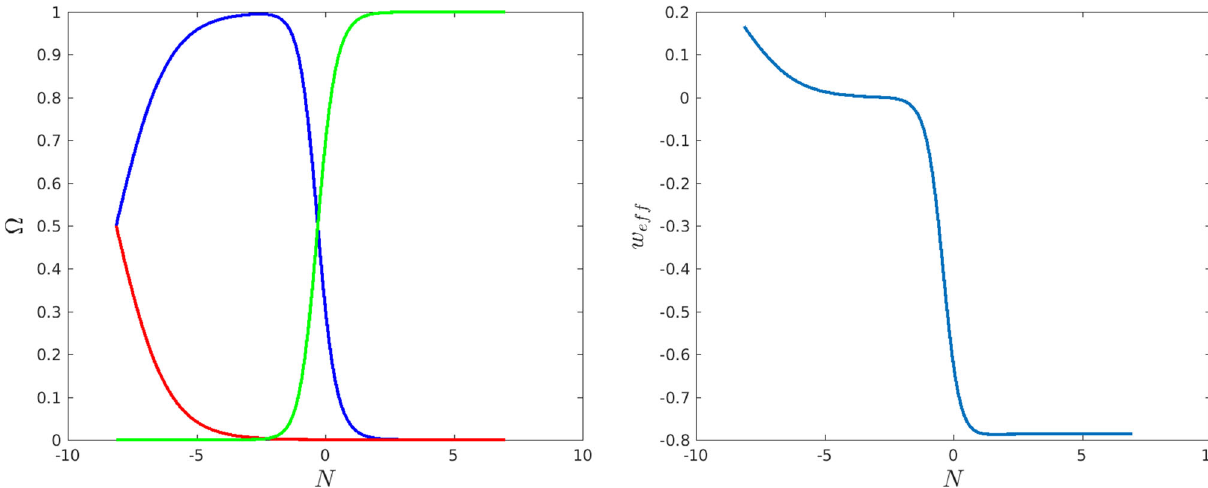
Fig. 4 Left panel: The density parameters (cid:4) m (blue curve), (cid:4) r (red curve), (cid:4) ϕ (green curve), from matter-radiation equality to the future have been depicted in the figure. Right panel: We show the qualitative